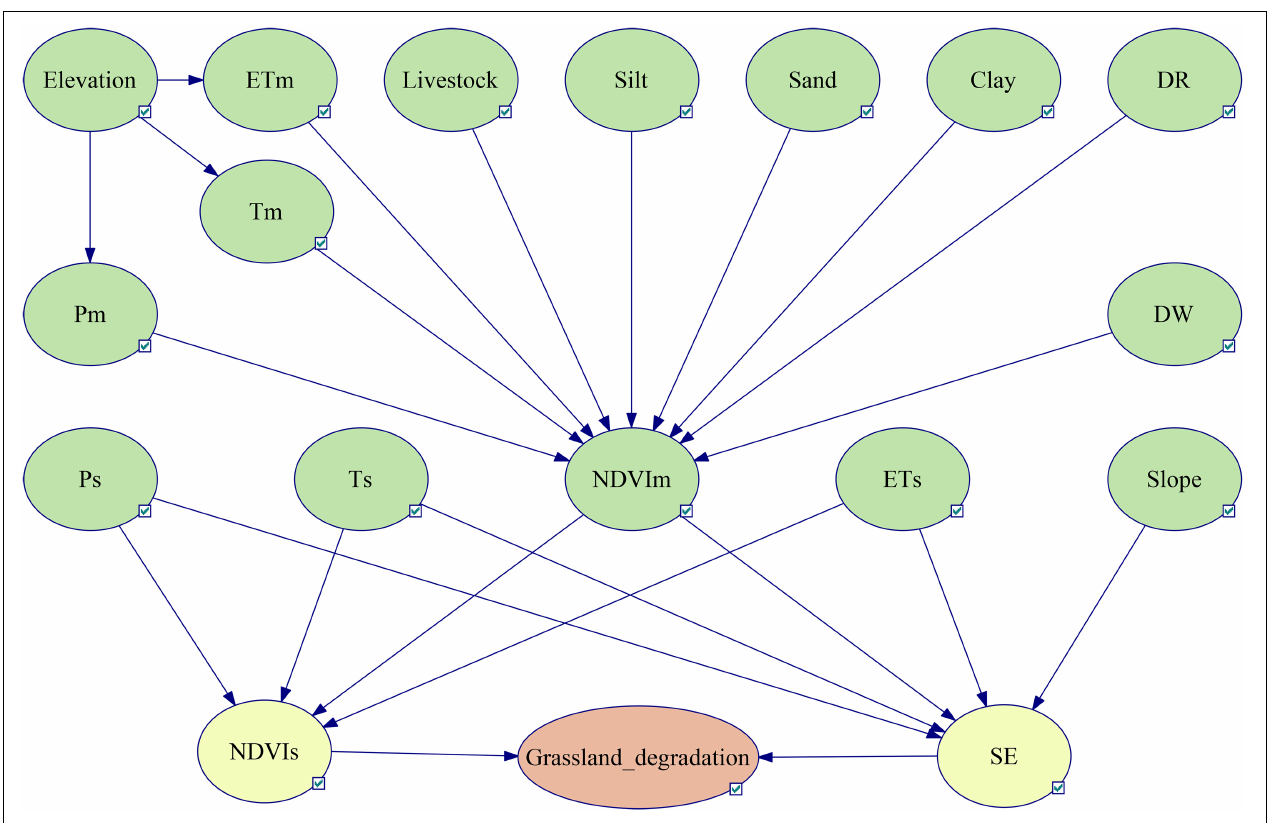
FIGURE 4 | Bayesian conceptual network of grassland degradation risk inference. NDVIs, slope of NDVI change; SE, shrub-encroached